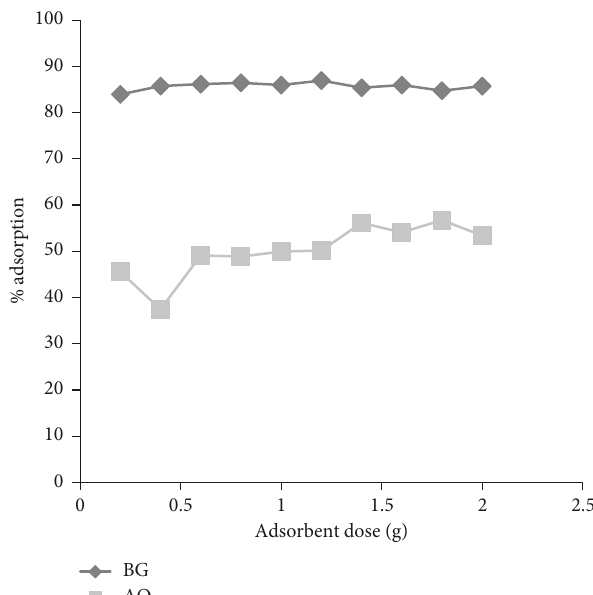
Figure 3: Graphical illustration of relative adsorbent dosage results for BG and AO-74 dye elimination by PR